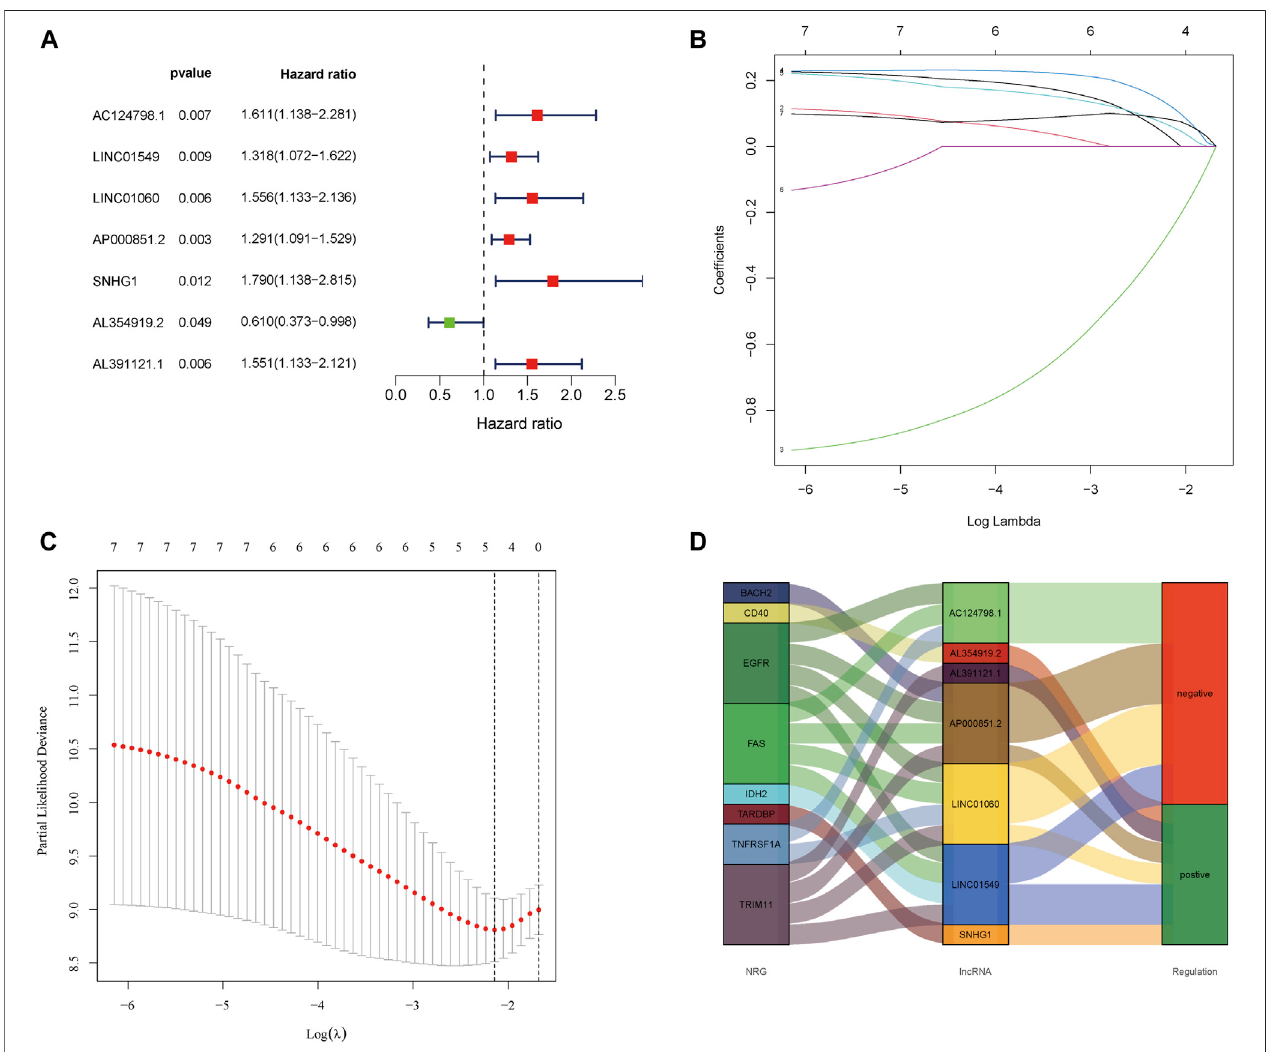
FIGURE2| Extractionoftheprognosticsignatureof fi nalnecroptosis-relatedlncRNAs. (A) UnivariateCoxregressionanalysisofprognosticlncRNAsinthetraining group. (B) LASSOcoef fi cient pro fi les ofnecroptosis-related lncRNAs inthe training group. (C) Partial likelihooddeviance ofprognosticsignature. (D) Sankeydiagram of necroptosis genes and related lncRNAs in the training